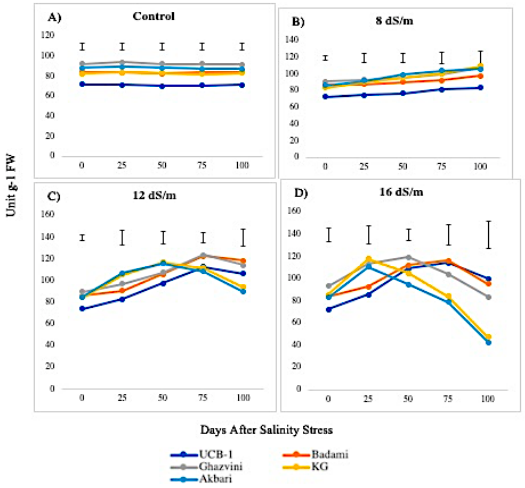
Figure 3. Effect of NaCl-mediated stress on POD activity in leaves of pistachio.